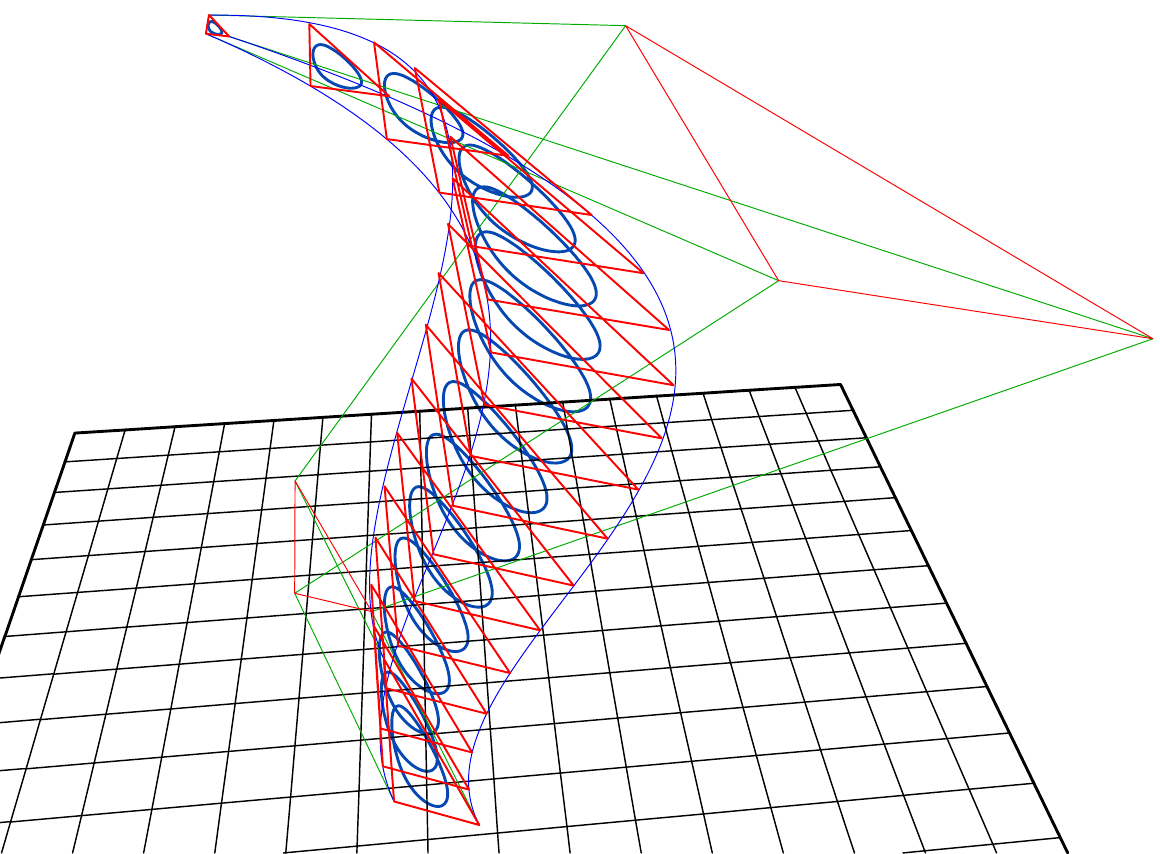
lines from the surface (red) used as construction for a secondary set of homothetic